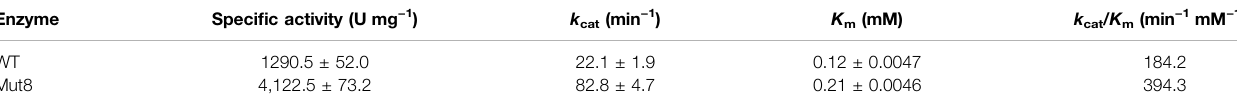
TABLE 3 | Speci fi c activity and kinetic parameters of WT PgUGT and Mut8. Enzyme